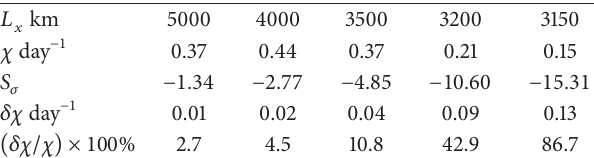
Table 2: Changes in the growth rates of unstable waves for the